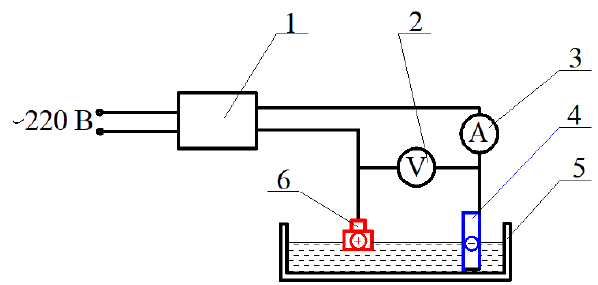
Fig. 1. Principlable electrical scheme of